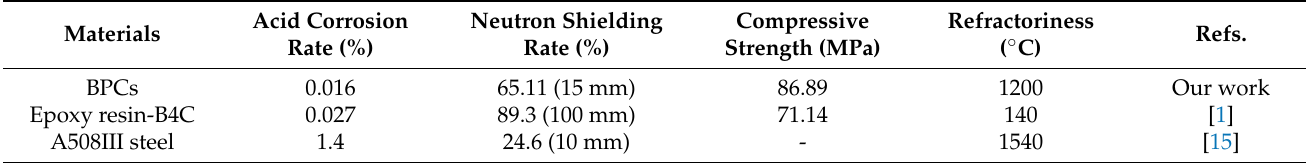
Table 6. Comparison of acid corrosion rate of different neutron shielding